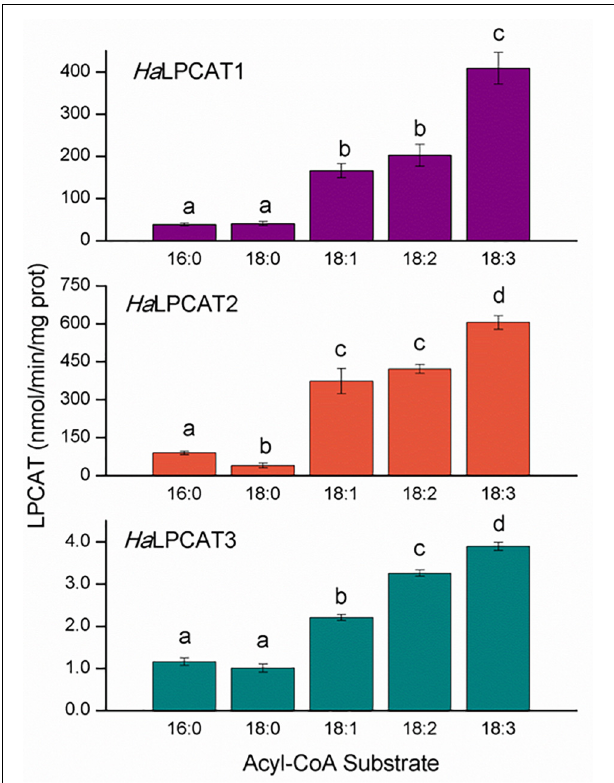
FIGURE 6 | Acyl-CoA specificity of the forward reaction catalyzed by microsomal recombinant HaLPCATs. In all cases, the glycerolipid substrate was sn -1-[1- 14 C]oleoyl-lyso phosphatidylcholine. Data are the mean of three replicates with ± standard deviation. The letters indicated the groups of statistical significance according to a one-way ANOVA with Tuckey post hoc analysis at a significance level of